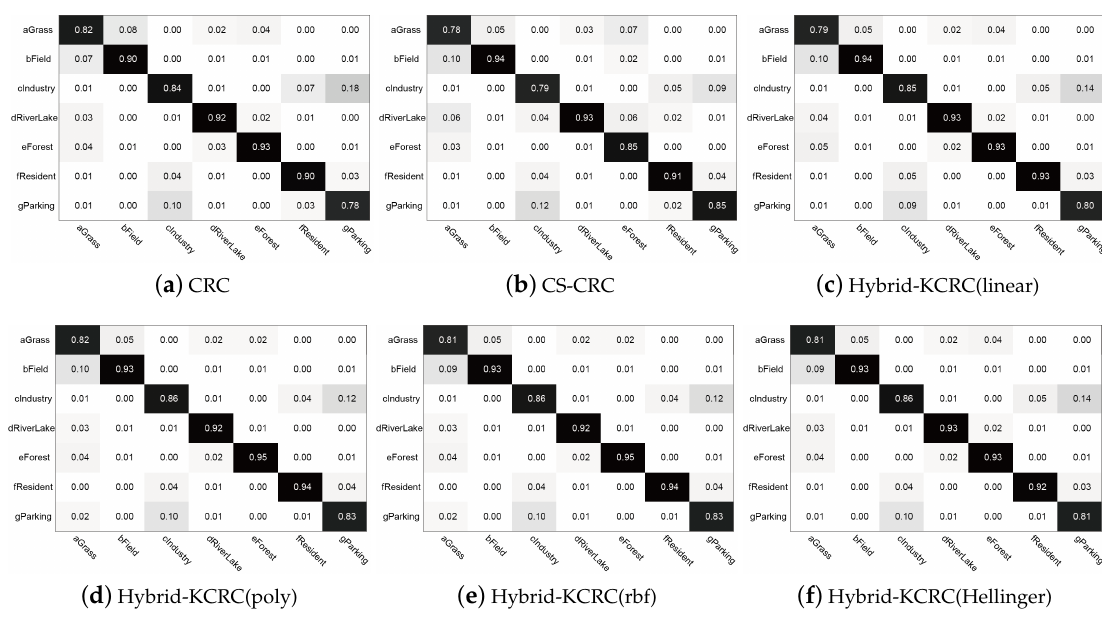
Figure 8. Confusion matrices on the RSSCN7 dataset.